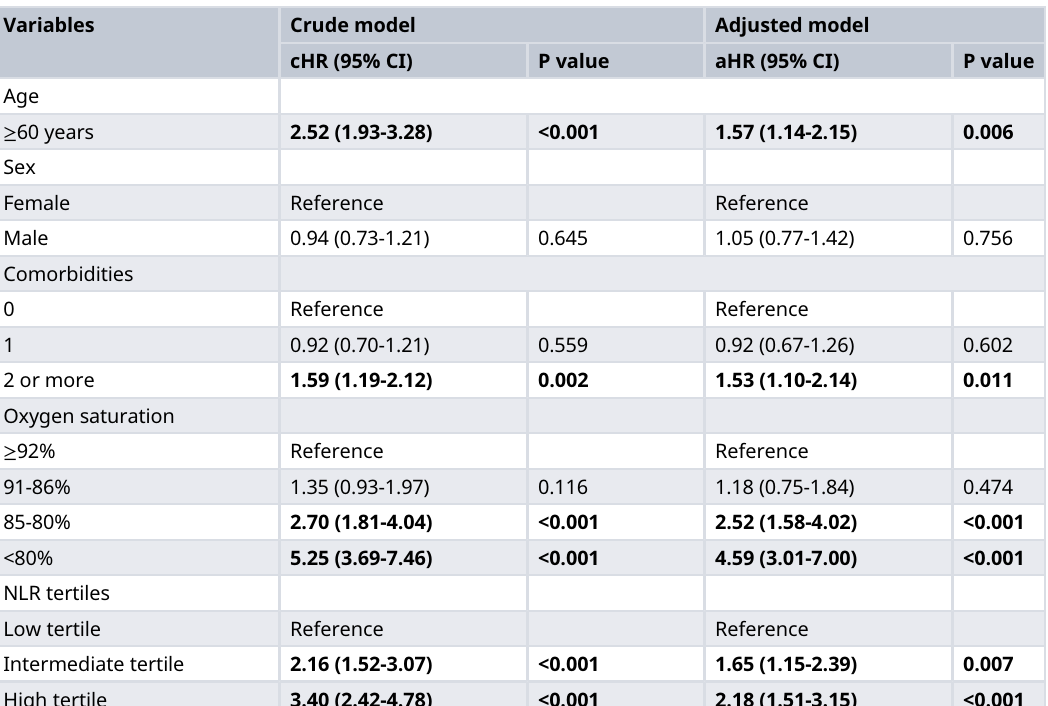
Table 3. Cox regression analysis to evaluate risk factors of mortality in the study